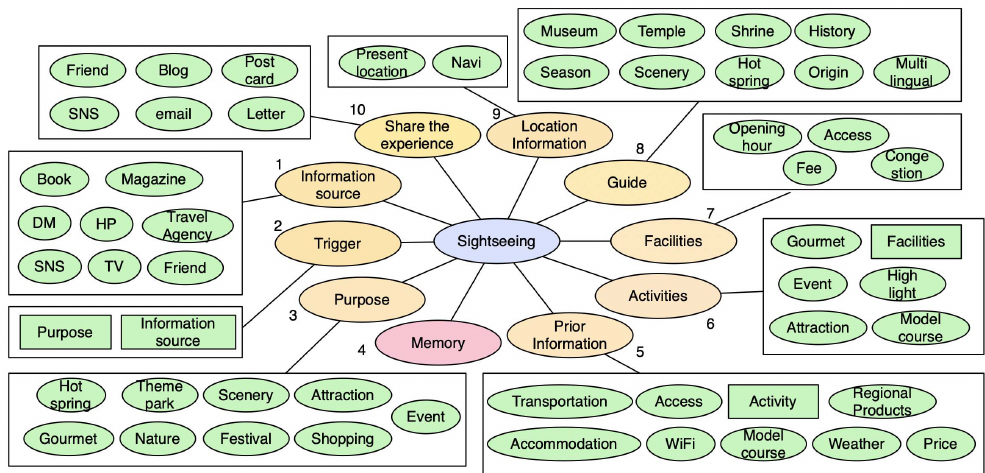
Figure 7. Categories of information of